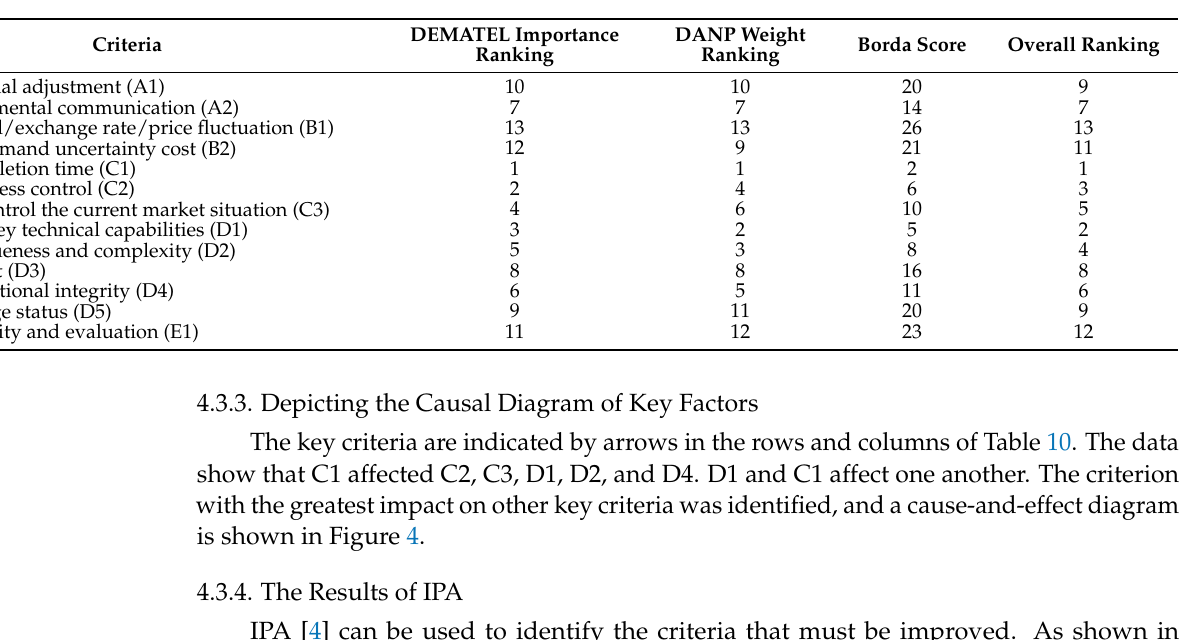
Table 9. Sorting summary of criterion weight.